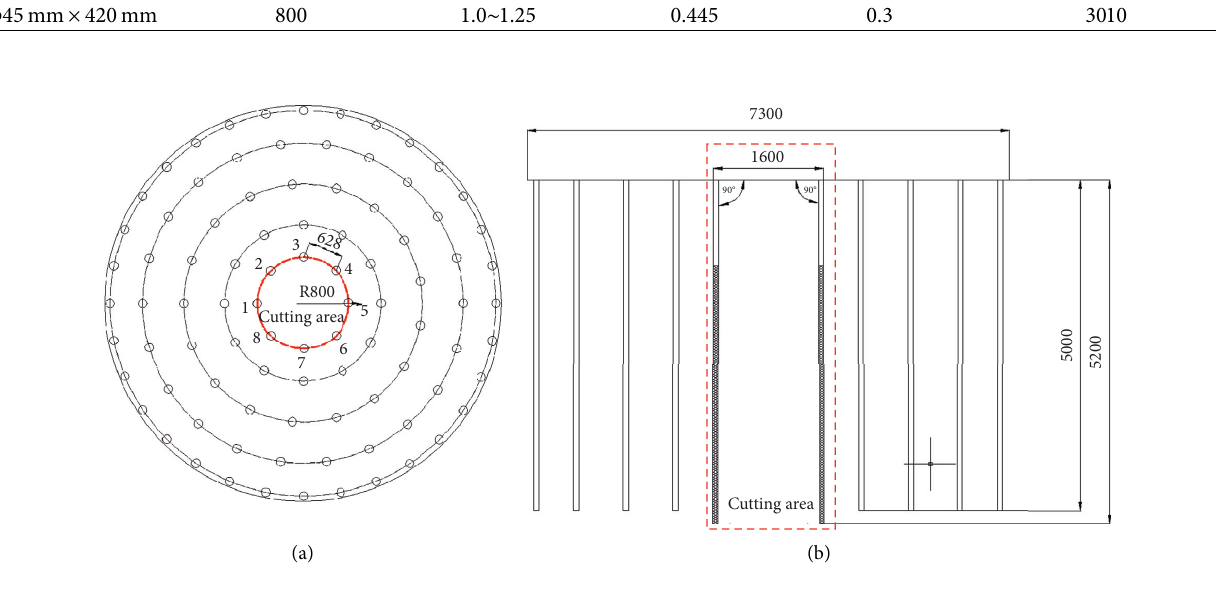
Figure 15: Original blasthole layout (unit:mm). Table 5: Original blasting parameters for the bedrock